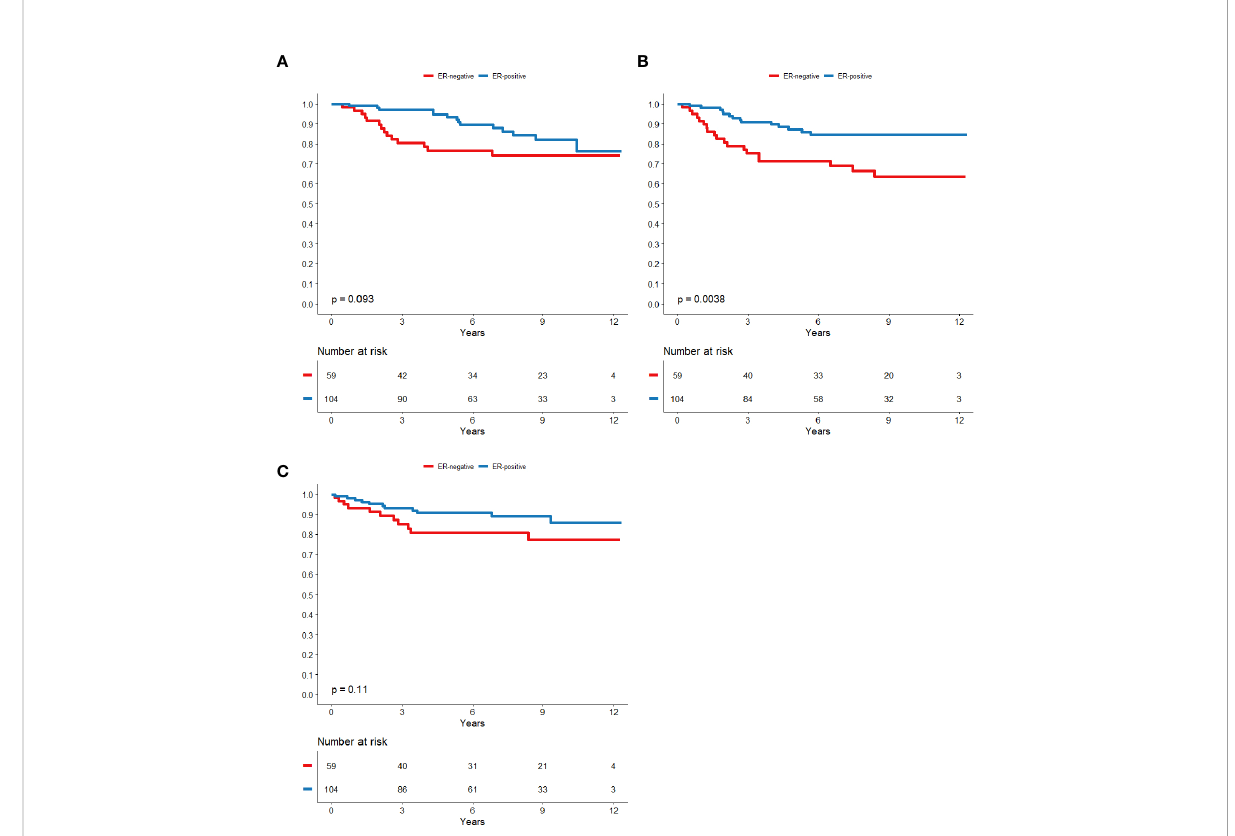
FIGURE 2 ER-status in relation to BCSS (A) , DRFS (B) and LRFS (C) respectively in patients that did not receive